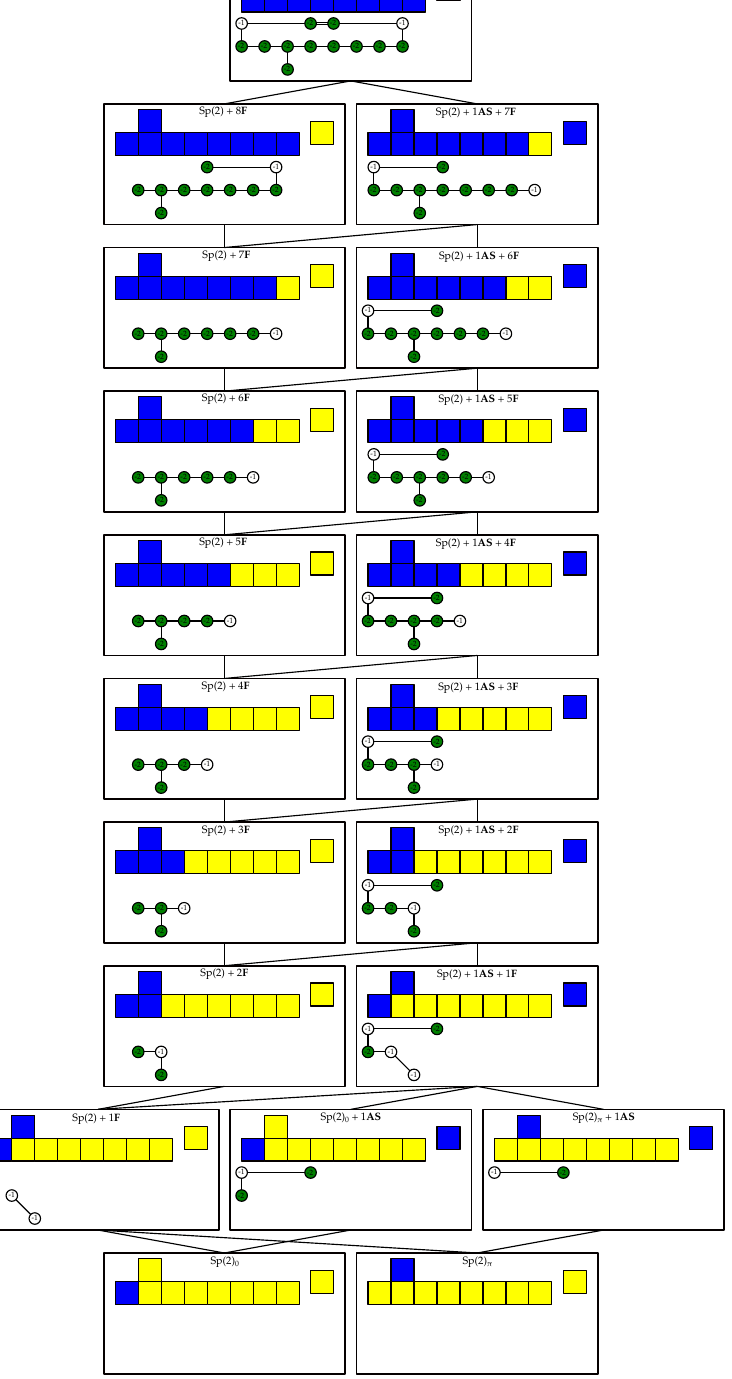
Figure 31. Rank two E-string with the marginal gauge theory described as Sp(2)+8 F +1 AS . The (cid:12)gure shows the tree of descendant theories, together with their superconformal (cid:13)avor symmetry, G F . We furthermore specify the reduced CFDs, which encode the (cid:13)avor symmetry and the ( (cid:0) 1) vertices that correspond to hypermultiplet matter in the Sp(2) description.